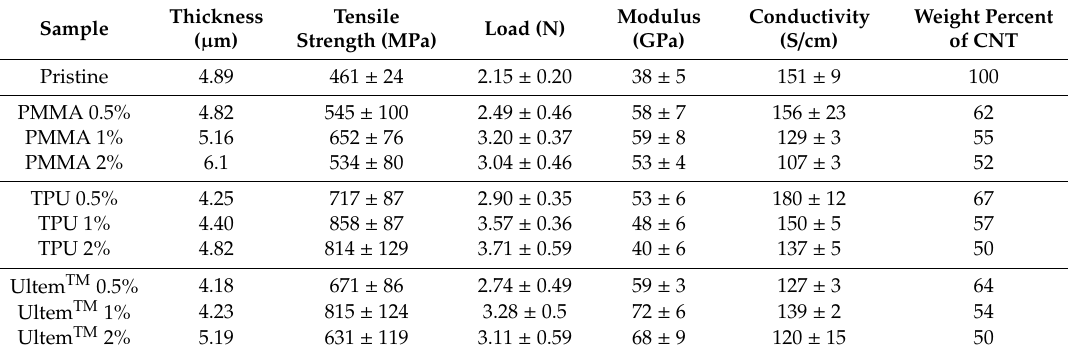
Figure 4. Stress vs. strain curves of the made CNT polymer composite sheets including Pristine, PMMA 1%, TPU 1% and Ultem 1% samples, respectively. Table 1. Physical properties of polymer-CNT composites at different CNT concentrations.